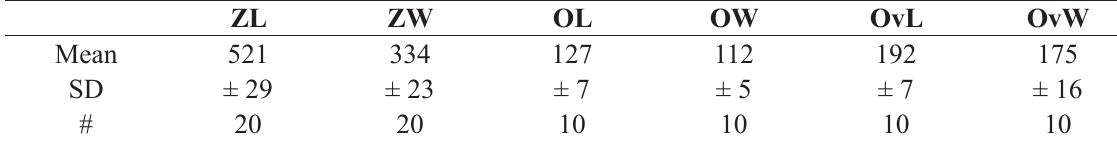
Table 2. Measurements of Atlantisina atlantis gen. et sp. nov.